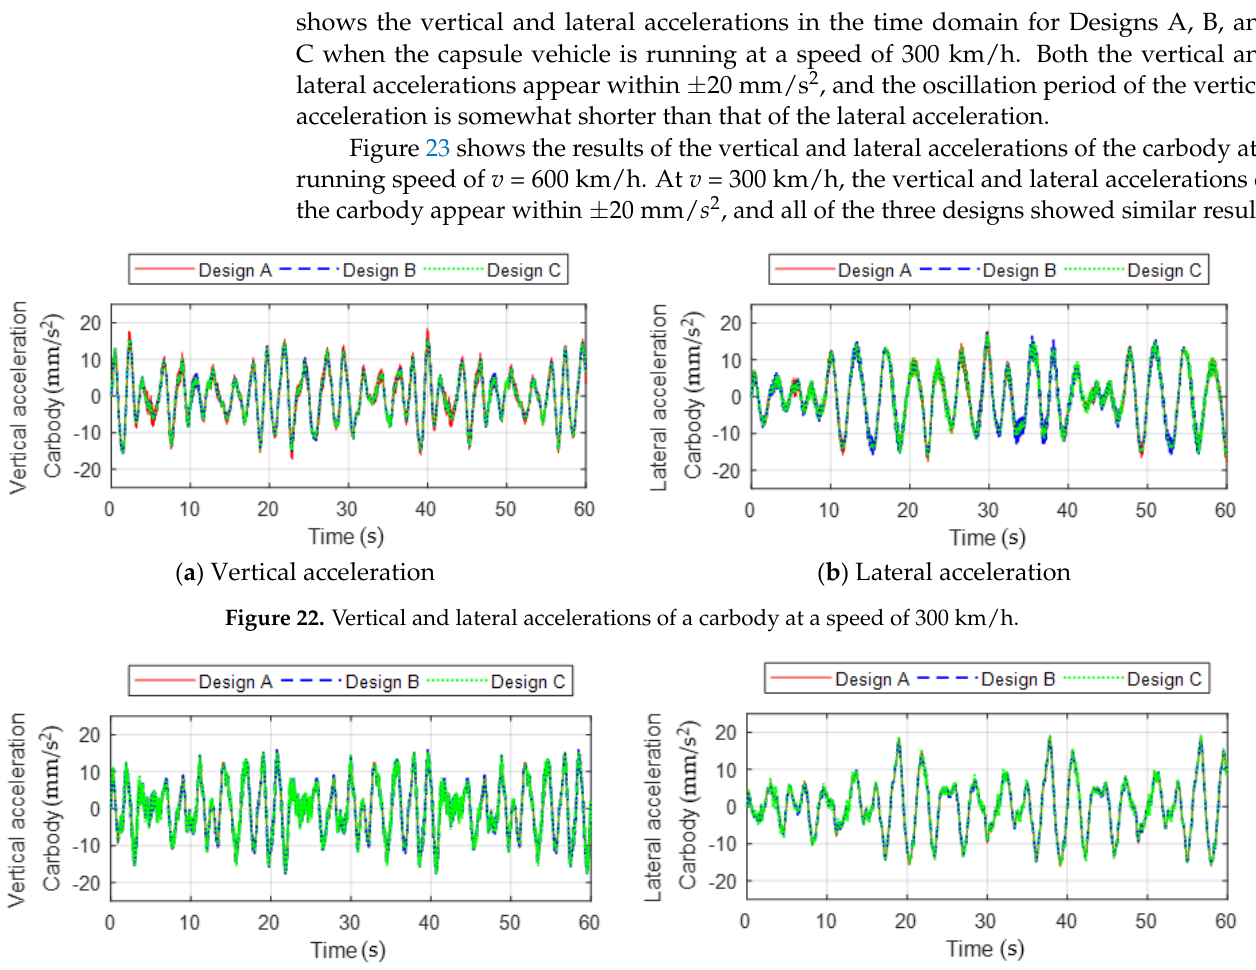
Figure 21. RMS value of the vertical/lateral displacements of the bogie with respect to speed.